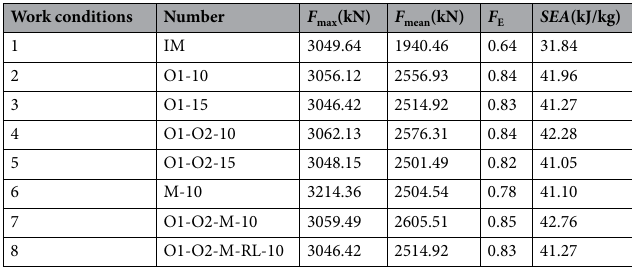
Table 2. Evaluation Indicators.